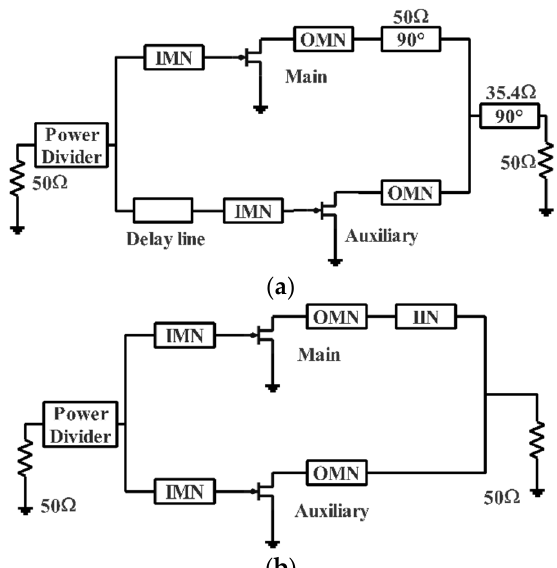
Figure 1. ( a ) The conventional Doherty power amplifier (DPA) (up); ( b ) The proposed asymmetric DPA (down).